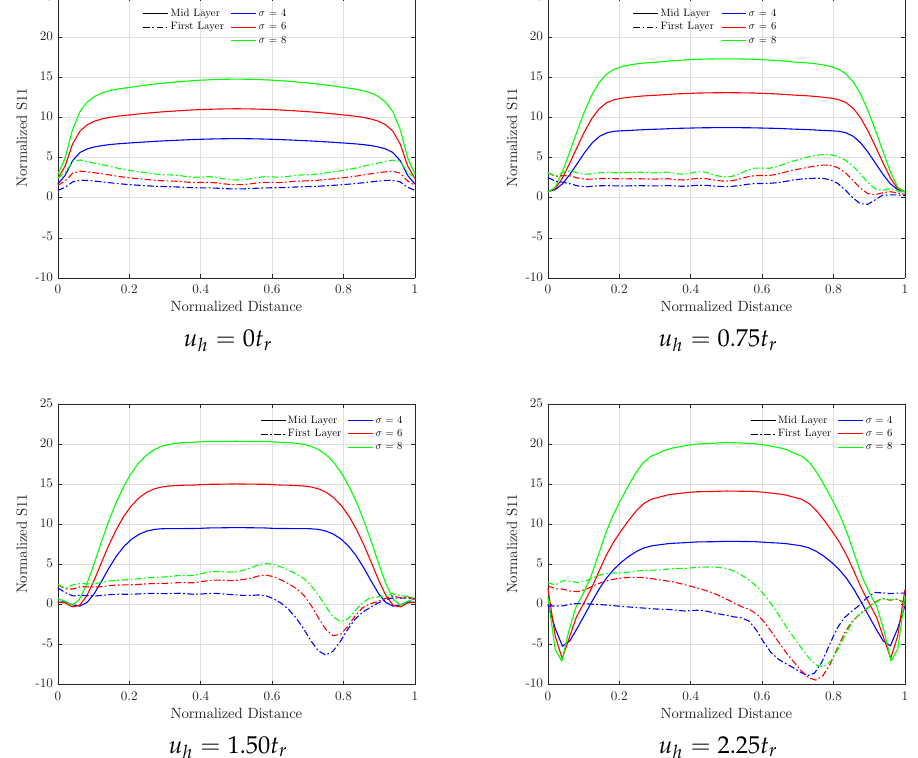
Figure 27. Axialstress S11 on reinforcement along the symmetry axis. Effect of vertical Pressure P . In Figure 28, a softening in the behavior and a corresponding increase in the equivalent damping coefficient with increasing pressure level can be